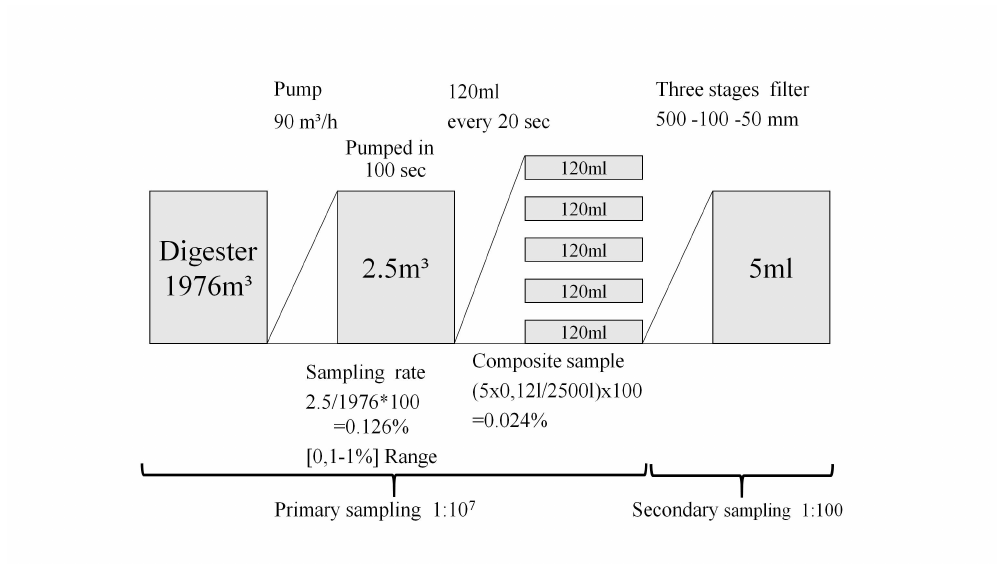
Figure 5. Sampling